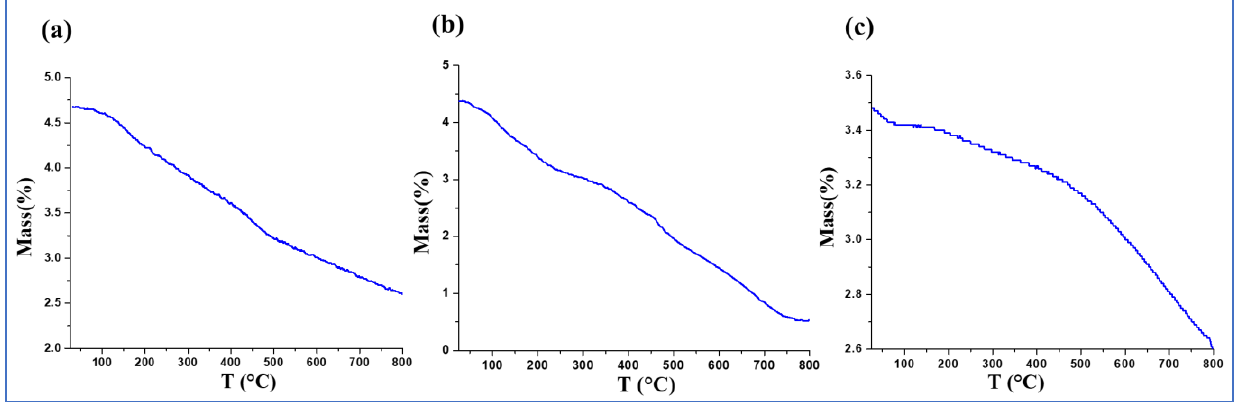
Figure 2. TGA of ( a ) GO-NCD- 1 ( b ) GO-NCD- 2, and ( c ) GO. The XRD spectra were measured in the range of 5 to 80°. In the case of GO, peaks were observed at 2 θ = 11.11°, 26.59°, 13.9°, and 10.54°, whereas GO-NCD- 1 showed peaks at 13.82°, 15.46°, 16.81°, and 26.4°. For GO-NCD-2, peaks were observed at 10.84°, 13.56°, 15.04°, 16.04°, 22.37°, 26.59°, and 38.95°. The peaks at 11.11° were assigned to the oxygenic functional groups and trapped water molecules of the graphene oxide. The broadening of the peaks of NCD 1 and NCD 2 were observed after their loading on graphene oxide, which could be due to the decrease in size from bulk to nanoscale dimensions (Figure 3, Figures S4 and S5). The broadening of the peaks around 26.59° suggested the functionalization of the major oxygen containing groups of the GO, therefore confirming the successful binding of both drug candidates on the nanodrug carrier [28–30].